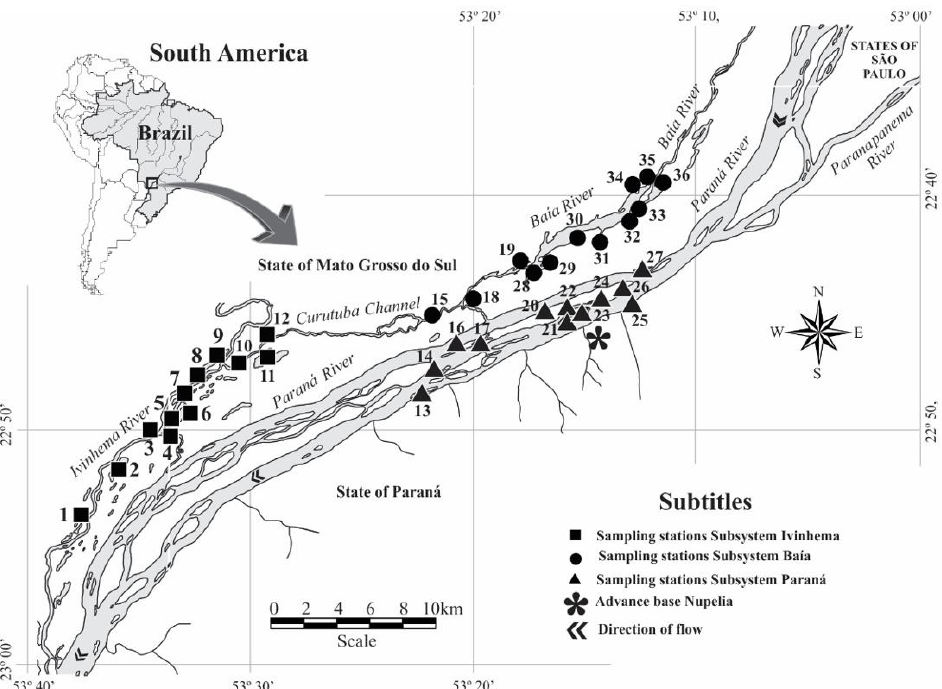
Figure 1. Sampled habitats in the Upper Paraná River floodplain. 1. Peroba L.; 2. Ventura L.; 3. Zé do Paco L.; 4. Ipoitã C.; 5. Boca do Ipoitã L.; 6. Patos L.; 7. Capivara L.; 8. Ivinhema R.; 9. Finado Raimundo L.; 10. Jacaré